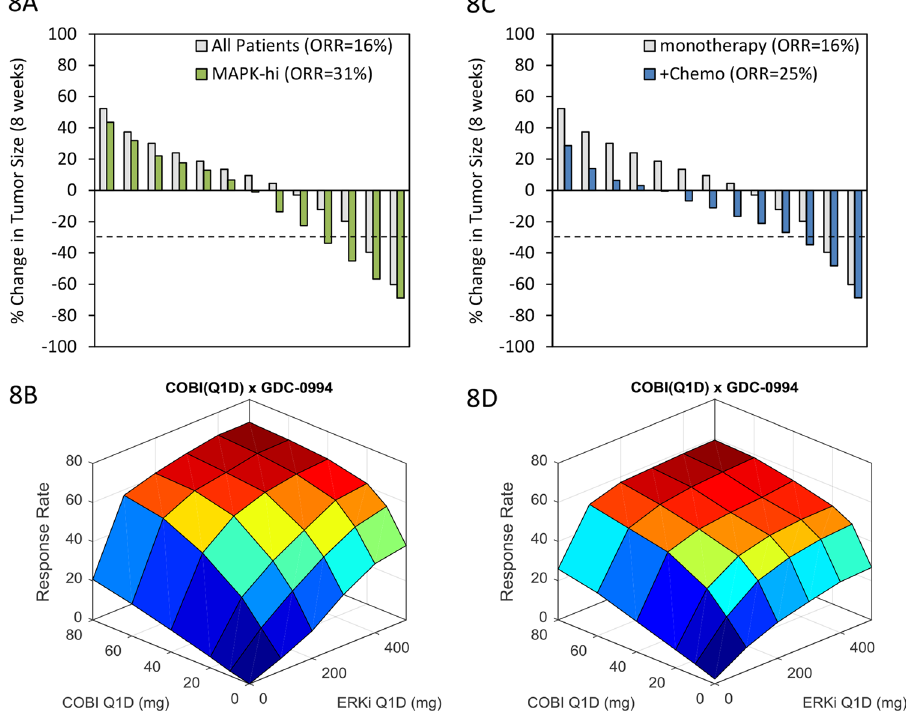
Fig. 8 Enhancement of GDC-0994/cobimetinib responses via biomarker strati fi cation or combination with additional anti-cancer agents. Simulated tumor responses (waterfall plots), and cobimetinb x GDC-0994 combination surface responses for a , b patients selected with greater than the 50-percentile MAPK-dependence, and c , d combination with another anti-cancer agent that increases the rate of cell death by 10% independent of MAPK of the population, and predicted results of the GDC-0994 cytotoxic chemotherapy, anti-apoptotic inhibitors, or immuno- monotherapy clinical trial (Fig. 8a) and GDC-0994 + cobimetinib therapies). We used the model to change these two clinical combination dose response surface (Fig. 8b) in this sub- scenarios. First, we simulated the effect of selecting virtual population. Second, we simulated the same clinical scenarios, patients with MAPK-dependence ( w OR ) in the top 50-percentile